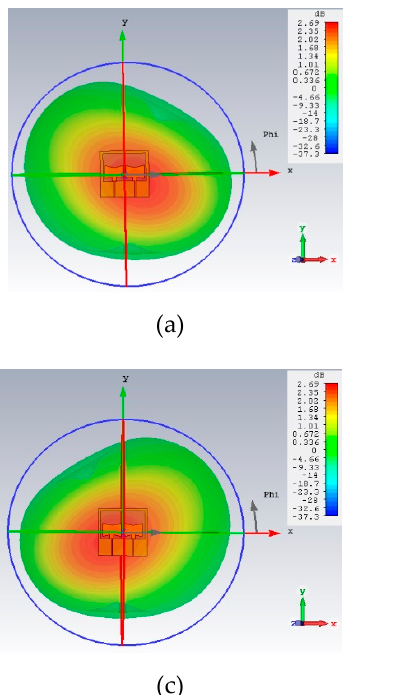
Figure 16. Results versus frequency when M-Net_2 is connected: ( a ) DC Voltage at the output of the rectifier (rec1) ( b ) power available at the input of the rectifier.